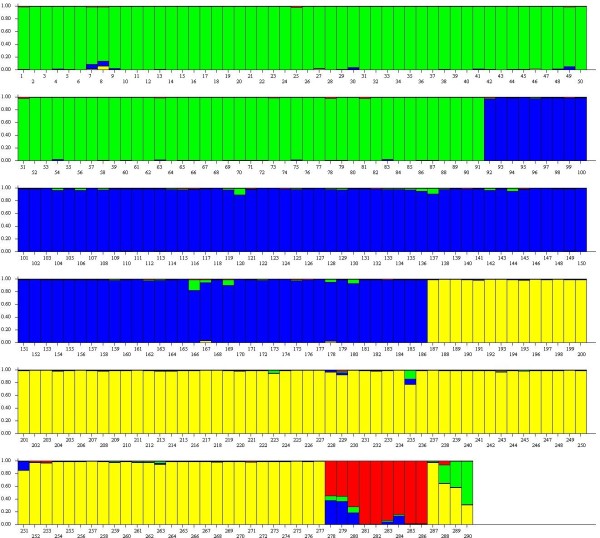
Identification of the hybrid minke whale and her female fetus based upon Bayesian cluster analysis. Each vertical line represents a single individual (which can be admixed), and each colour a genetic cluster. Columns 1–91 = B. a. acutorostrata, 92–186 = B. a. scammoni, 187–277 = B. bonaerensis, 278–286 = B. a. unnamed subspecies = “Dwarfs”, 287 = B. bonaerensis long-distance captured in the Arctic in 1996 [6], 288 = first documented hybrid between minke whale species captured also in the Arctic in 2007 [6], 289 = mother hybrid minke whale captured in 2010 documenting first pregnant hybrid between minke whale species, 290 = fetus for individual 289 representing the first documented example of back-crossing between any whale species.